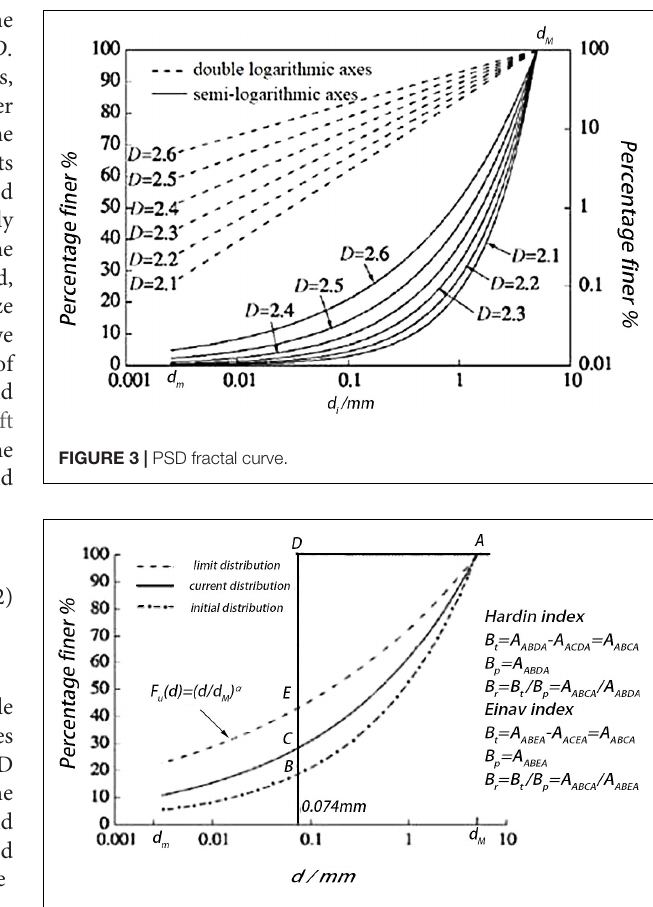
FIGURE 4 | Definition of breakage